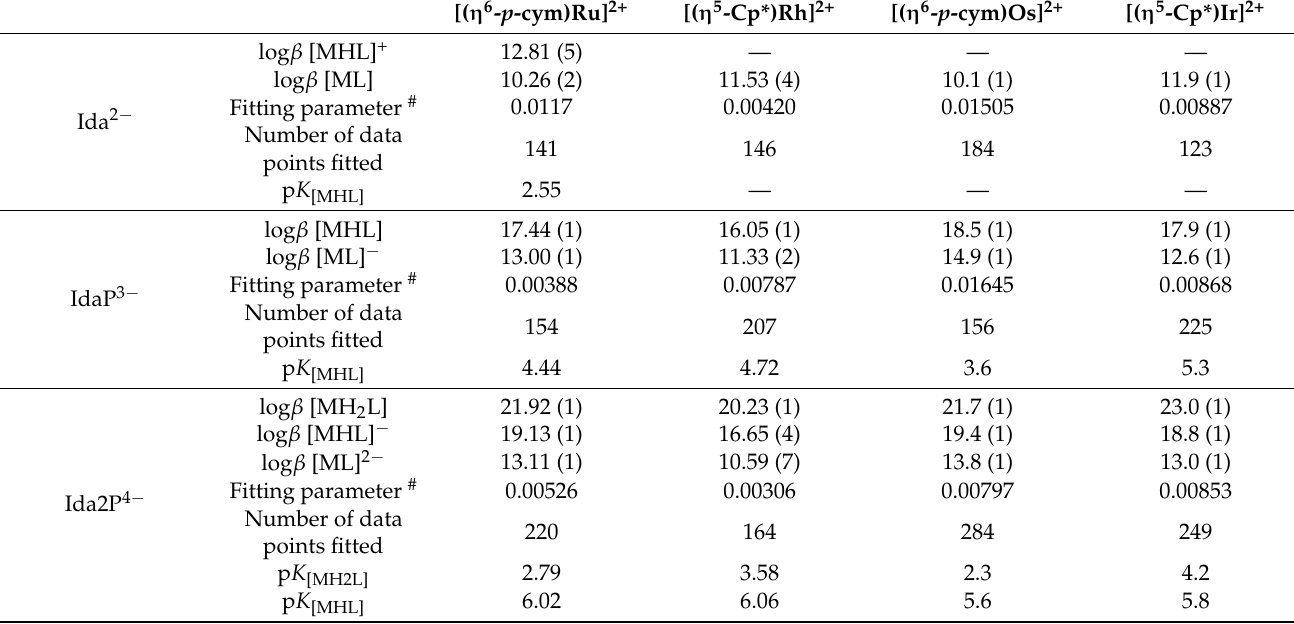
[( η 6 - p -cym)Ru] 2+ [( η 5 -Cp*)Rh] 2+ [( η 6 - p -cym)Os] 2+ [( η 5 -Cp*)Ir]